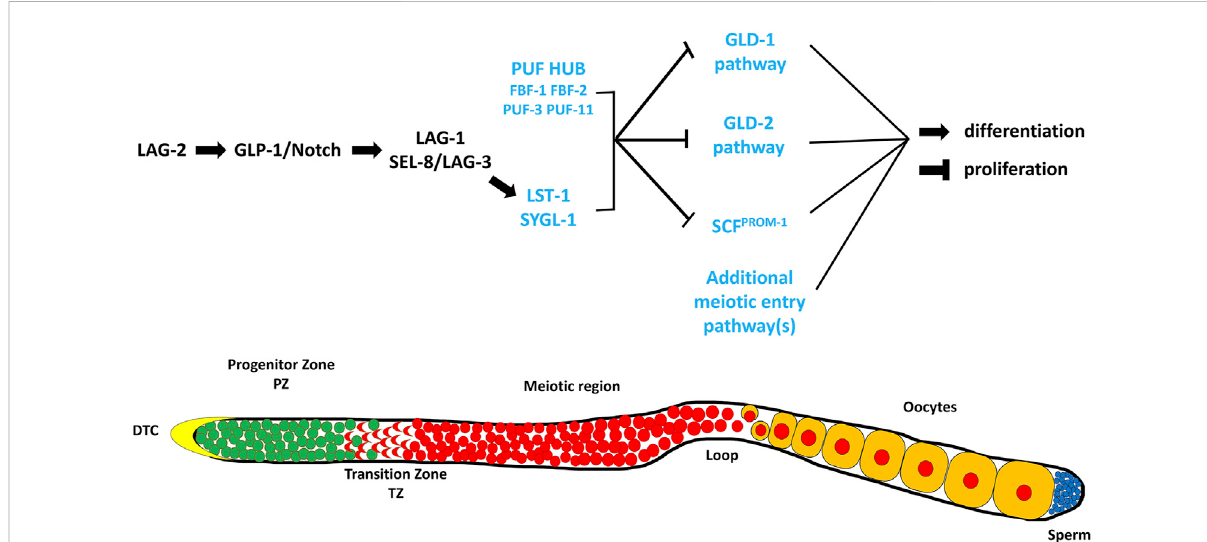
FIGURE 1 A simpli fi ed representation of the genetic pathway regulating the balance between GSC proliferation and differentiation in the germline of C. elegans (Adaptedfrom(HubbardandSchedl,2019)).TheDSLligand,LAG-2,isexpressedonthesurfaceoftheDTCwhereitinteractswiththeGLP-1/ Notch receptor present on the membrane of the GSCs. This interaction results in the formation of a downstream transcriptional activation complex that activates the expression of LST-1 and SYGL-1. These two proteins work with components of the PUF HUB (FBF-1, FBF-2, PUF-3, and PUF- 11) and promote proliferation and/or inhibit meiosis through repressing the downstream meiotic entry pathways, GLD-1 (GLD-1, NOS-3) , GLD-2 (GLD-2, GLD-3), SCF PROM − 1 (SKR-2, CUL-1, PROM-1). The proteins and/or pathways whose elimination does not cause a major disruption in the proliferation vs. differentiation decision, except in a sensitized background, are labeled in blue. Below is a cartoon representation of a wildtype C. elegans hermaphrodite germline (Adapted from (Vanden Broek, 2021)). The distal end is on the left capped by the Distal Tip Cell (DTC). Green cells represent mitotic cells, red cells represent meiotic cells, blue cells represent mature sperm, and yellow cells represent developing oocytes.